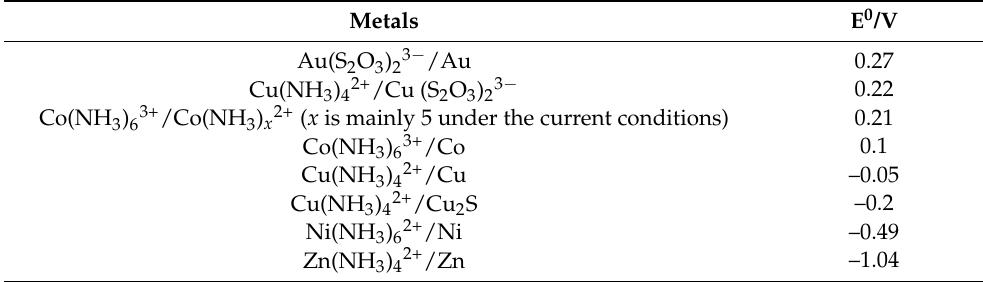
Table 1. Standard redox potentials of Au, Cu, Co, Ni, and Zn in ammonium thiosulfate systems [33–37].